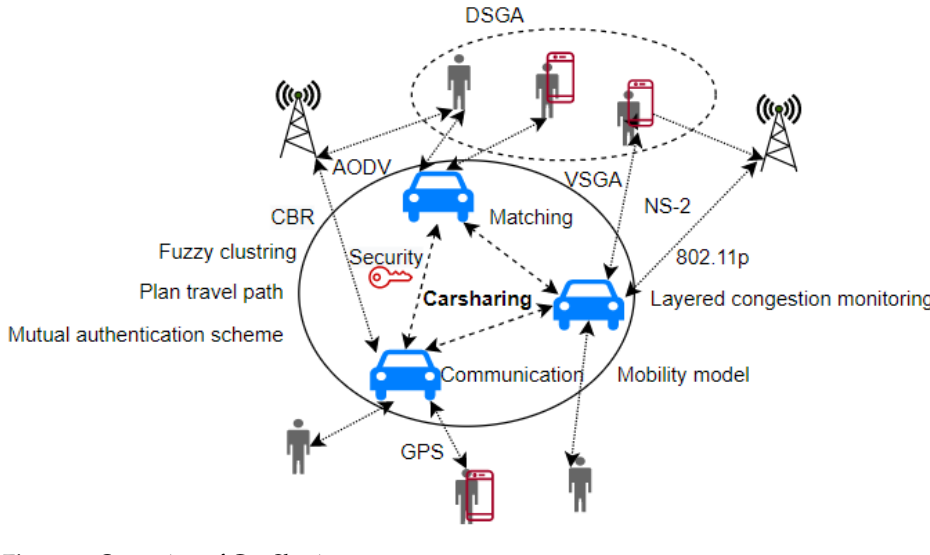
Figure 5. Operation of Car